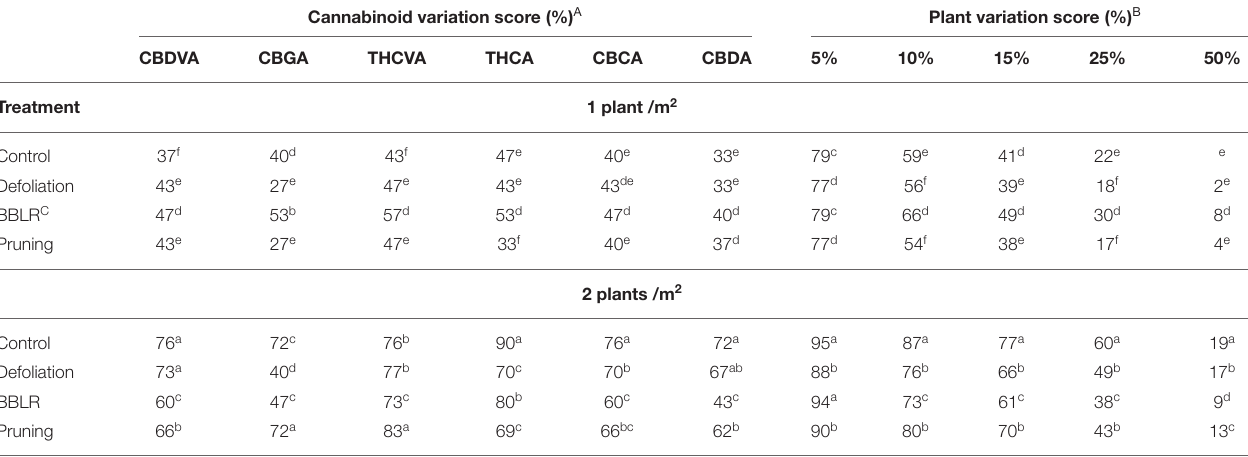
TABLE 3 | Effect of plant density (1 and 2 plants/m 2 ) and architectural modulation treatments on chemical uniformity of cannabinoids in Cannabis sativa plants D . Cannabinoid variation score (%)